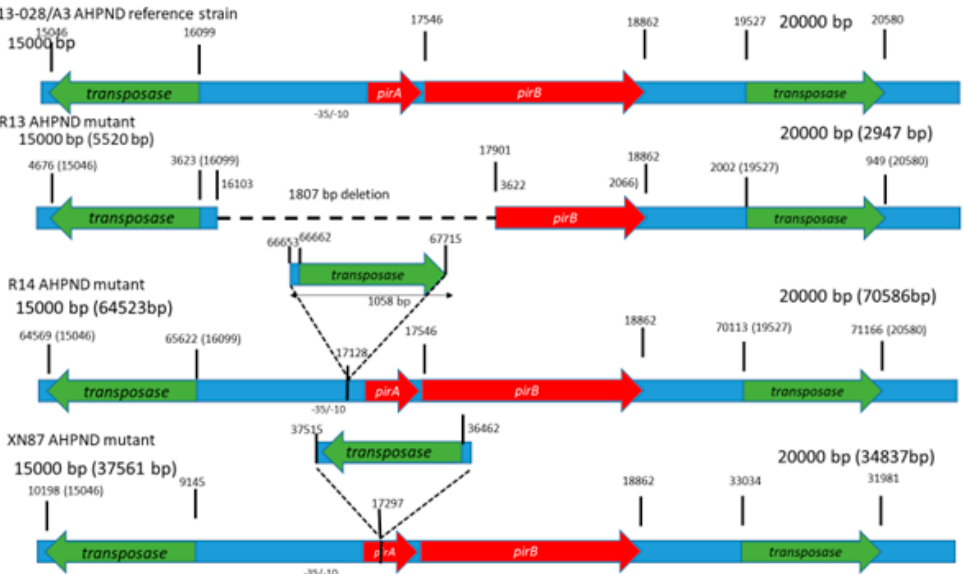
Figure 6. Comparison of the normal pVA3 plasmid (strain A3) and their mutated forms in isolate R13 and R14. (a) Scaled diagram of the pir A and pir B toxin gene regions in the normal pVA3 plasmid. (b) Mutant strain R13. Dash lines denote the absence of pir A. (c) Mutant strain R14. Notice insertion upstream of pir A. (d) XN87 AHPND mutant. The numberx over the gene organization schematics indicate the nucleotide position.